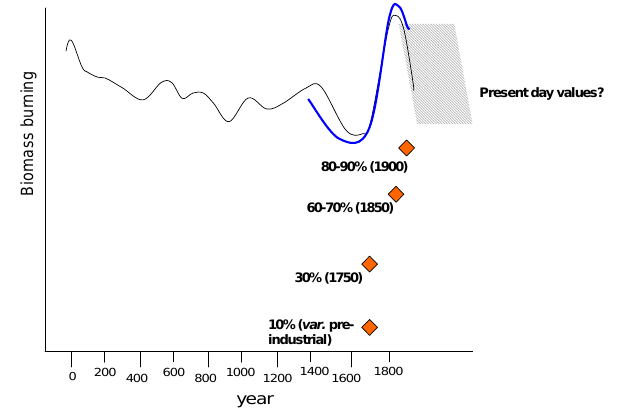
Fig. 5. Changes in global biomass burning over the last 2 millennia, derived from charcoal indices (black line; Marlon et al., 2008), and for the Southern Hemisphere over the last few centuries, derived from CO measurements in ice cores (blue line; Wang et al., 2010). Lines are redrawn from Prentice (2010), and changes are indicated as relative only, without scale. Diamonds indicate various assump- tions about pre-industrial wildfire emissions with respect to present day (Ito et al., 2007; Lamarque et al., 2010; Mieville et al., 2010; Dentener et al., 2006a). Years in brackets are the years chosen for the base-line simulations. The “10%” assumption has been used in a number of studies and for a number of different base-line years (var. pre-industrial). The grey shaded area indicates the uncertain pyrogenic emissions from the middle of the 20th to early 21st cen- tury, which cannot be derived from ice core or sediment charcoal